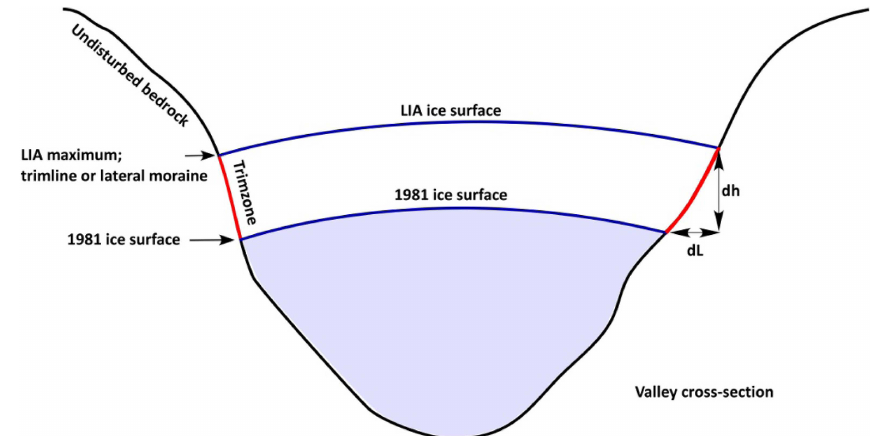
Figure 6. Sketch of outlet glacier perpendicular to the flow direction. Points are placed at the trimline or lateral moraine marking the LIA max position and at the 1981 ice surface. The vertical difference (d h ) is the thinning at each sample location.